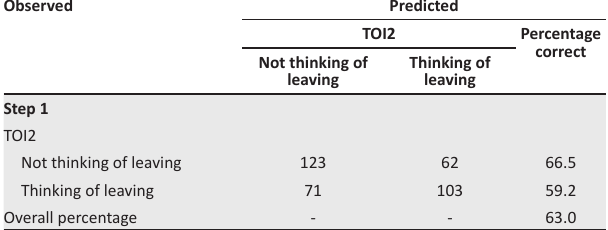
TABLE 2: Classification table for turnover